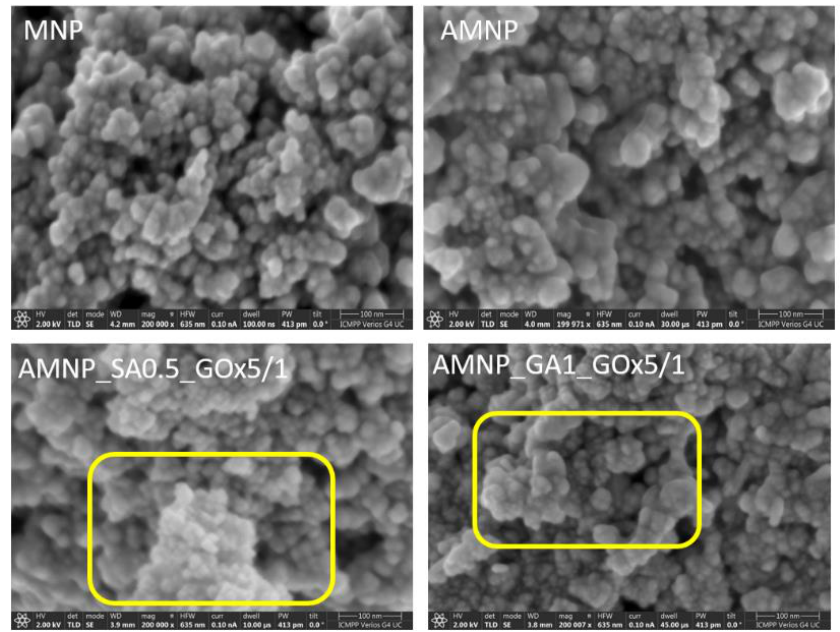
Figure 6. Optical microscopy data for MNPs, AMNPs and enzyme-conjugated